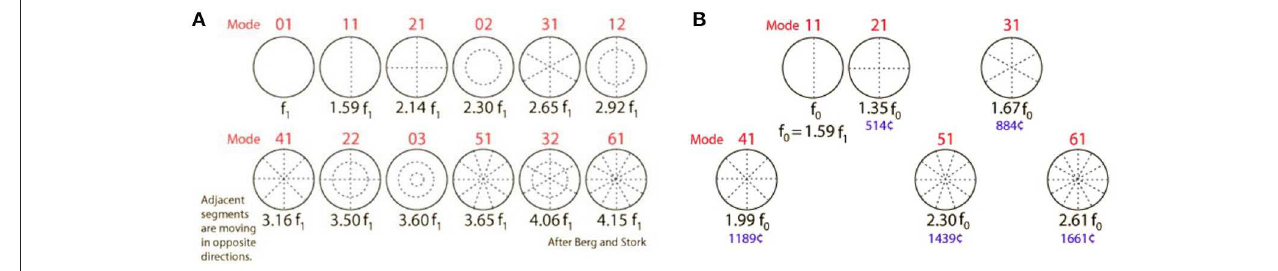
FIGURE 3 | (A) Modes of an ideal circular membrane. When the air is not compressed in a cavity, the membrane vibrates freely in the (0,1) mode, which does not produce a pleasing tone and is detrimental to pitch and sound quality (see also: https://www.acs.psu.edu/drussell/demos/membranecircle/circle.html). Note the non-harmonicity when all modes are excited. (B) In the music instrument called “kettle drum” or “timpani,” compression of the air in the bowl results in damping of the unwanted and disturbing fundamental (0,1) mode; and correct tempering results in quasi-alignment of the preferred modes, so that a quasi-harmonic series of overtones is formed. This series defines pitch, harmonicity, timbre, and clarity of the sound. The middle ear cavity exerts a similar effect on TM resonance frequencies. R. Nave, with permission: https://www.mwit.ac.th/~physicslab/hbase/music/cirmem.html.